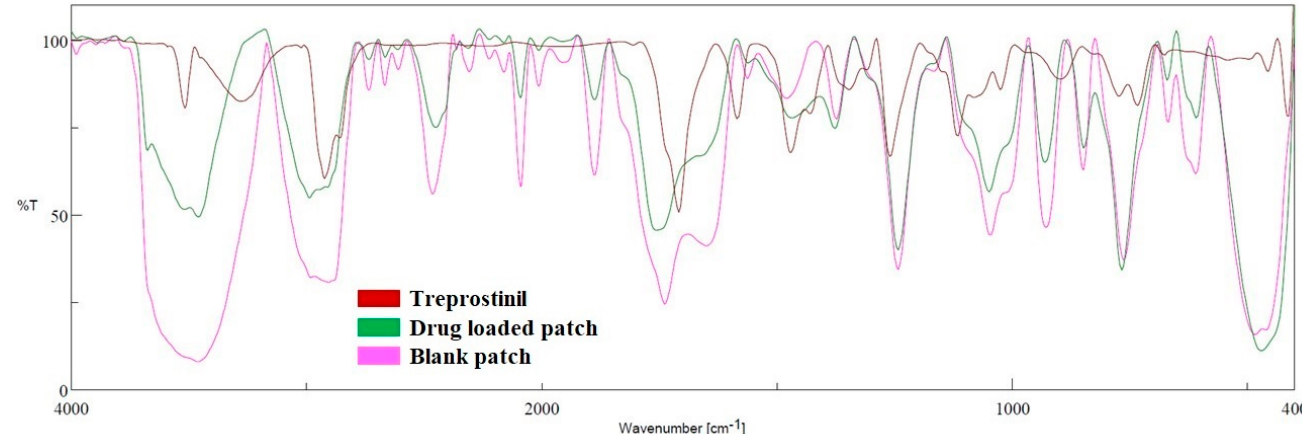
Table 5. Absorption peaks of treprostinil observed in FTIR and its corresponding functional groups.